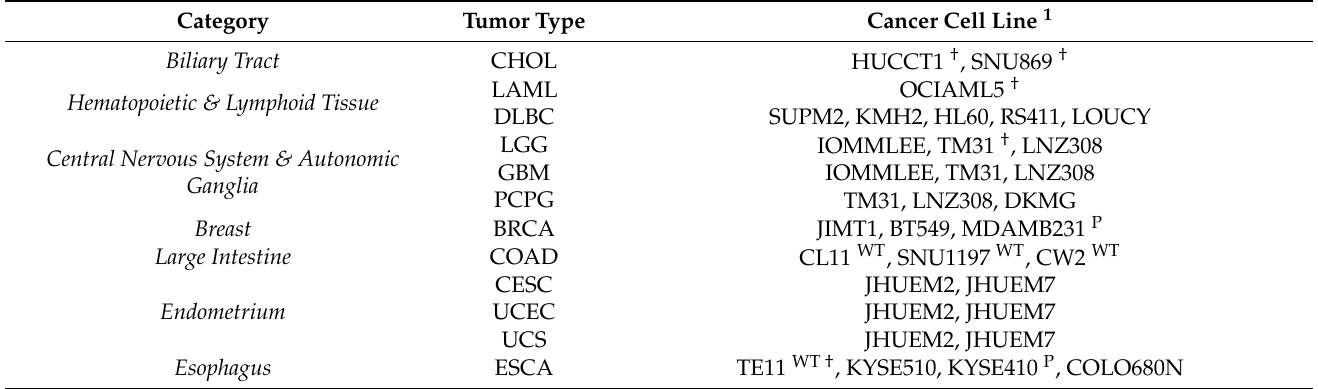
Table 2. Cancer cell lines clustered to related tumors based on TERT isoform expression patterns 309